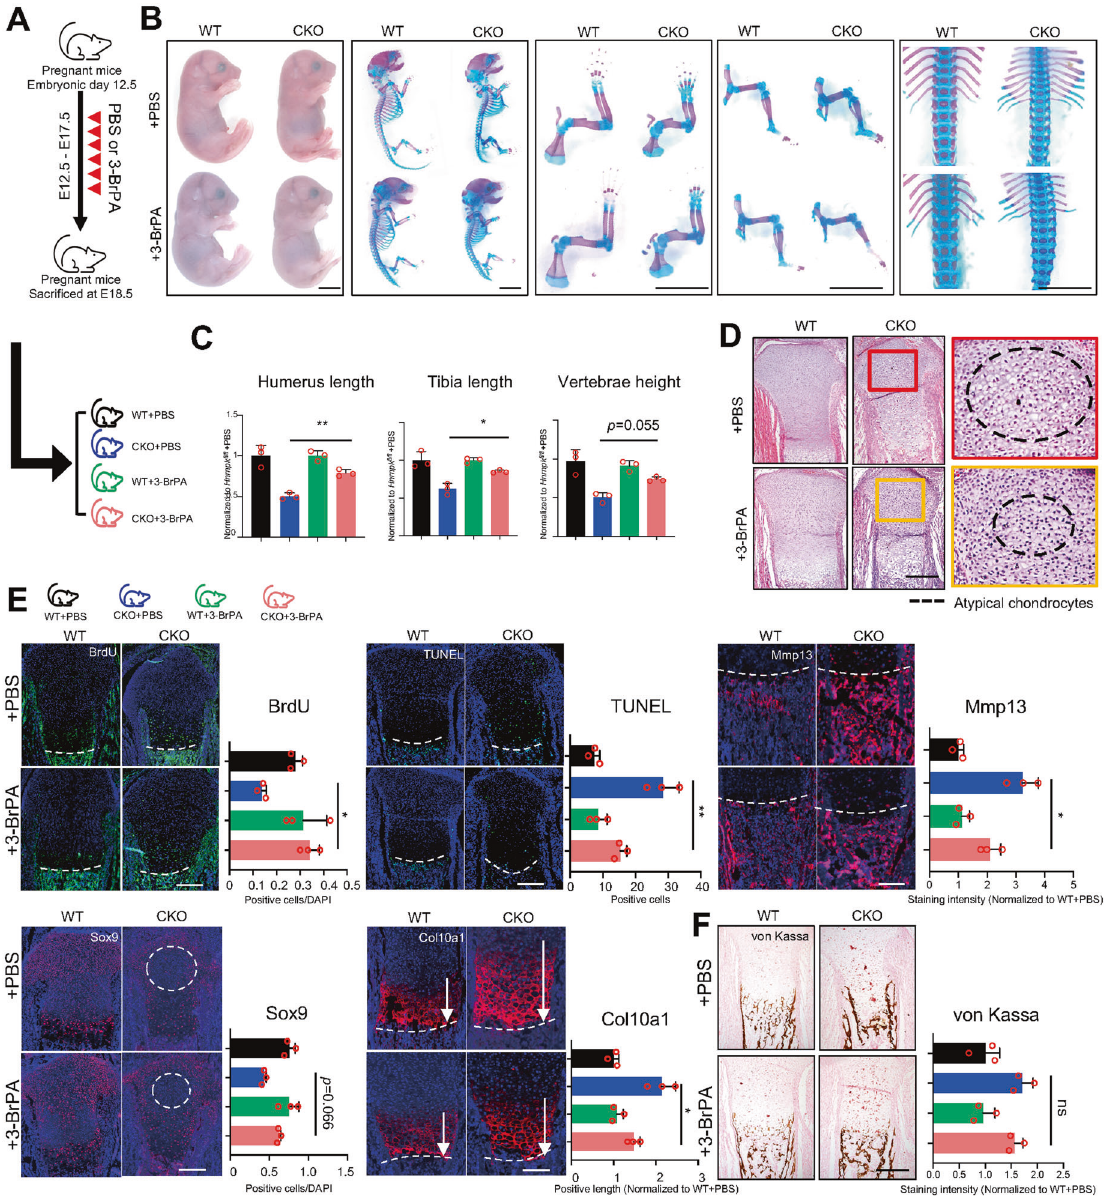
Fig. 6 Suppressing glycolytic intensity partially rescues dwar fi sm phenotype in CKO embryos in vivo. A Diagram of strategy about intraperitoneal injection of PBS or 3-BrPA and corresponding possible offspring. B General inspection and skeletal preparation of E18.5 embryos delivered from pregnant mice injected with PBS or 3-BrPA. Scale bar: 1 mm. C Quanti fi cation of humerus length (left panel), tibia length (middle panel), and vertebrae height (right panel) according to skeletal preparation of E18.5 embryos delivered from pregnant mice injected with PBS or 3-BrPA. Statistical analysis was exerted between CKO + PBS and CKO + 3-BrPA groups. n = 3 biological replicates. D H&E staining of tibia of E18.5 embryos delivered from pregnant mice injected with PBS or 3-BrPA. Boxes: magni fi cation of resting zone in growth plate. Dotted circles: the area where atypical chondrocytes exist. Scale bar: 100 μ m. E Immunostaining of BrdU assay, TUNEL assay, Sox9, Col10a1, and Mmp13 of tibia of E18.5 embryos delivered from pregnant mice injected with PBS or 3-BrPA and corresponding quantitative analysis. Statistical analysis was exerted upon CKO + PBS and CKO + 3-BrPA groups. Dotted lines: boundary between hypertrophic zone and POC. Dotted circles: the area where atypical chondrocytes exist. White arrows: positive range of Col10a1. n = 3 biological replicates. Scale bar: 100 μ m. F von Kassa staining of tibia of E18.5 embryos delivered from pregnant mice injected with PBS or 3-BrPA and quantitative analysis. n = 3 biological replicates. Scale bar: 100 μ m. p -value was calculated by one-way ANOVA followed by Tukey ’ s multiple comparisons tests. Data were shown as mean ± SD. * p < 0.05; ** p < 0.01; *** p < 0.001; ns: not signi fi